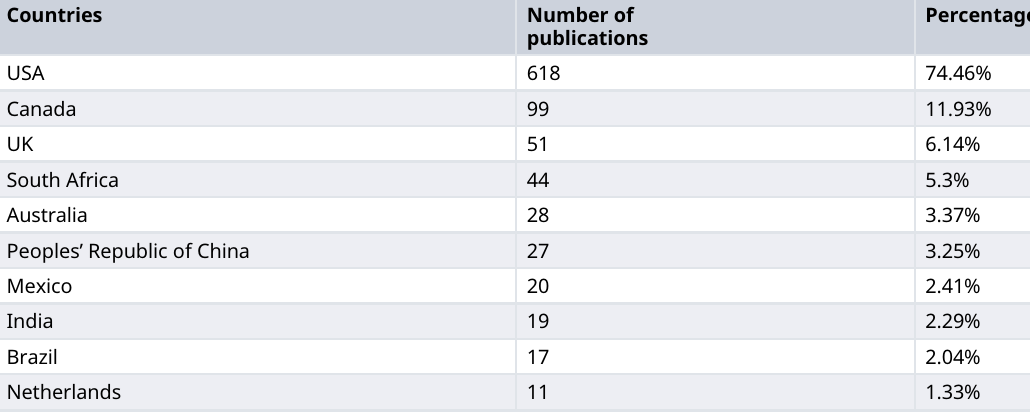
Table 6. Top contributing countries on syndemics